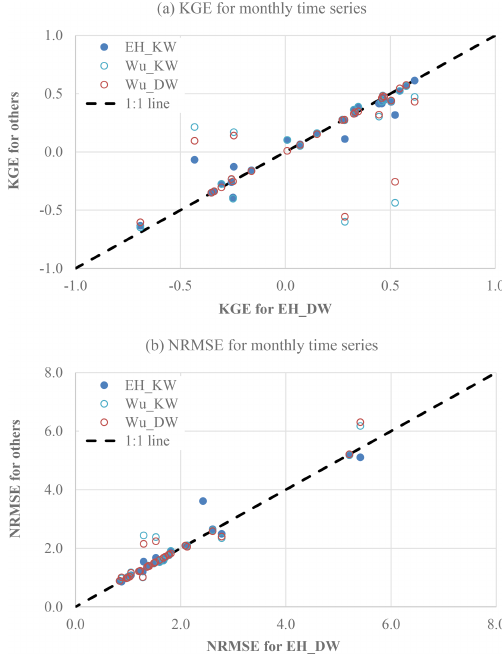
Figure 7. Comparison of model structure in terms of KGE and NRMSE between the simulated and observed monthly time series at different USGS gauges. EH and Wu stand for Engelund–Hansen and Wu’s formulas, respectively. DW and KW stand for the diffu- sion and kinematic wave routing methods,